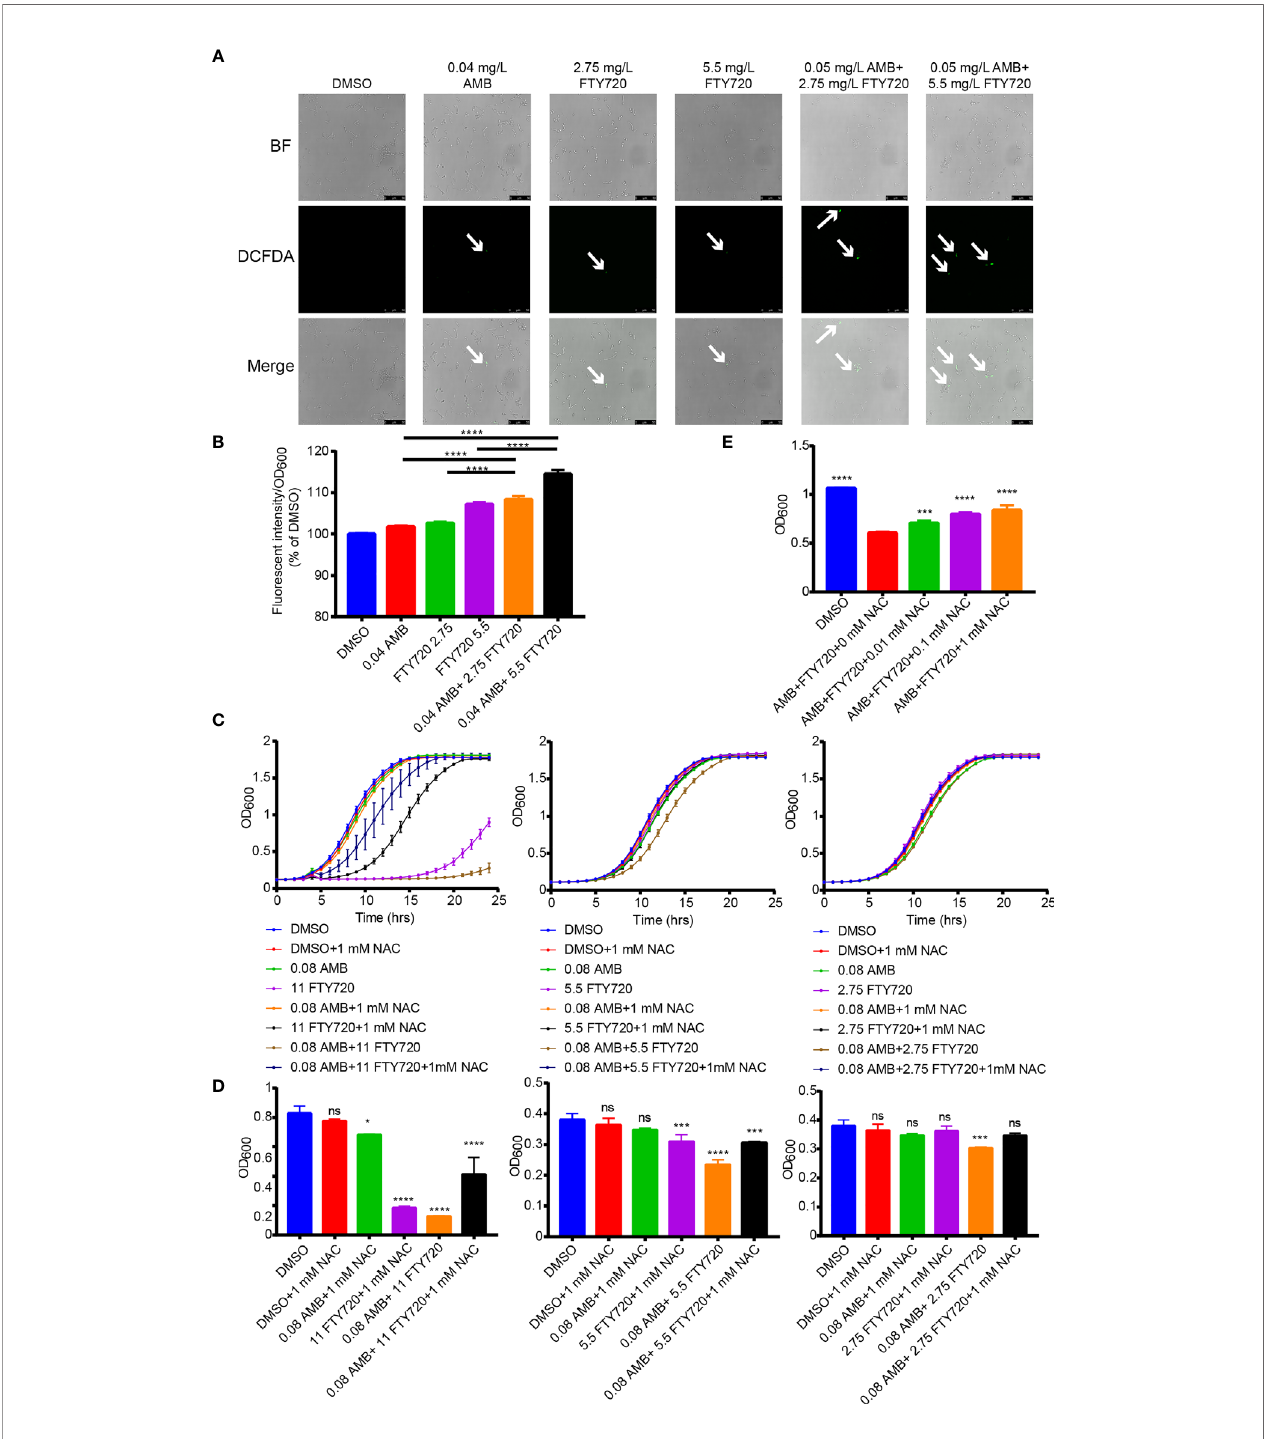
FIGURE 4 | Combination of FTY720 and AMB induced ROS hyperaccumulation and increased activity of SOD and CAT in C. albicans . (A) ROS generation in C. albicans cells stimulated by 0.04 mg/L of AMB and 5.5 or 2.75 mg/L of FTY720 loaded with 50 µM fl uorescent dye, 2 ′ ,7 ′ -dichlorodihydro fl uorescein diacetate (H 2 DCFDA) (BF, bright fi eld). (B) Fluorescent intensity of ROS in C. albicans cells treated by 0.04 mg/L AMB and 5.5 or 2.75 mg/L FTY720. (C) Cells were treated with single or combination of 0.08 mg/L AMB and 11, 5.5, or 2.75 mg/L FTY720 with/without 1mM NAC. The OD 600 was obtained every 60 min in a BioTek plate reader for 24 hours. (D) Cell growth was quanti fi ed after incubation for 8 hours. (E) Cell growth was quanti fi ed after treatment with single or combination of 0.08 mg/ L AMB and 2.75 mg/L FTY720 with/without various concentrations of NAC. Results are represented by the mean ± SD of three biological replicates. * P < 0.05 vs control, *** P < 0.001 vs control, **** P < 0.0001 vs control. ns, not signi fi cant vs